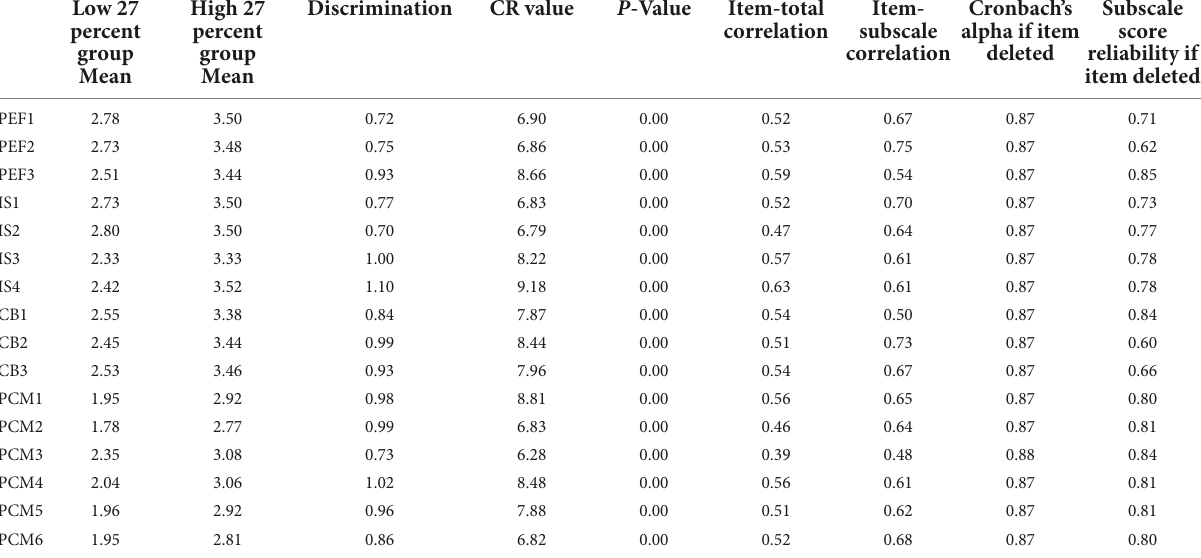
TABLE 4 Item analysis